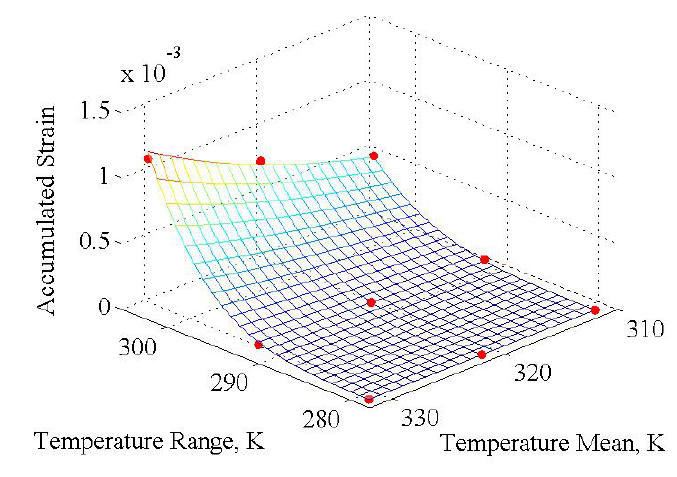
Figure 3. Estimated surface plot defined in Equation (9) where red dots represent design points, temperature in